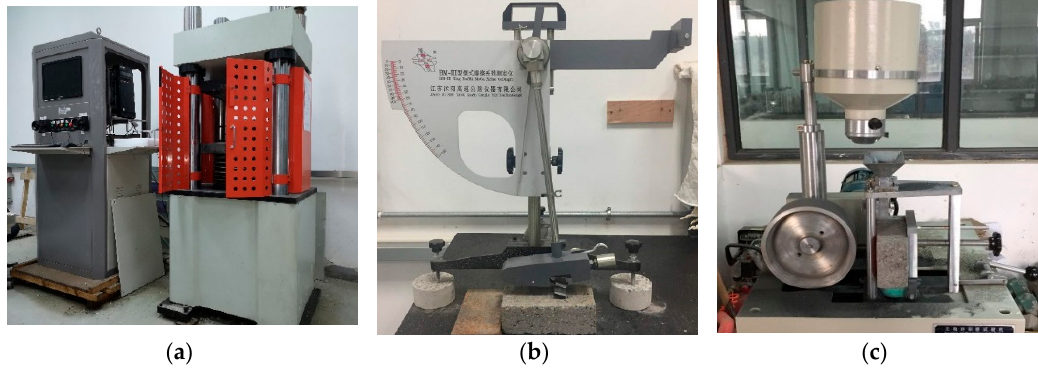
Figure 4. Test equipment in this series of experiments; ( a ) compression testing machine; ( b ) pendulum friction test equipment; ( c ) unglazed brick abrasion testing machine.